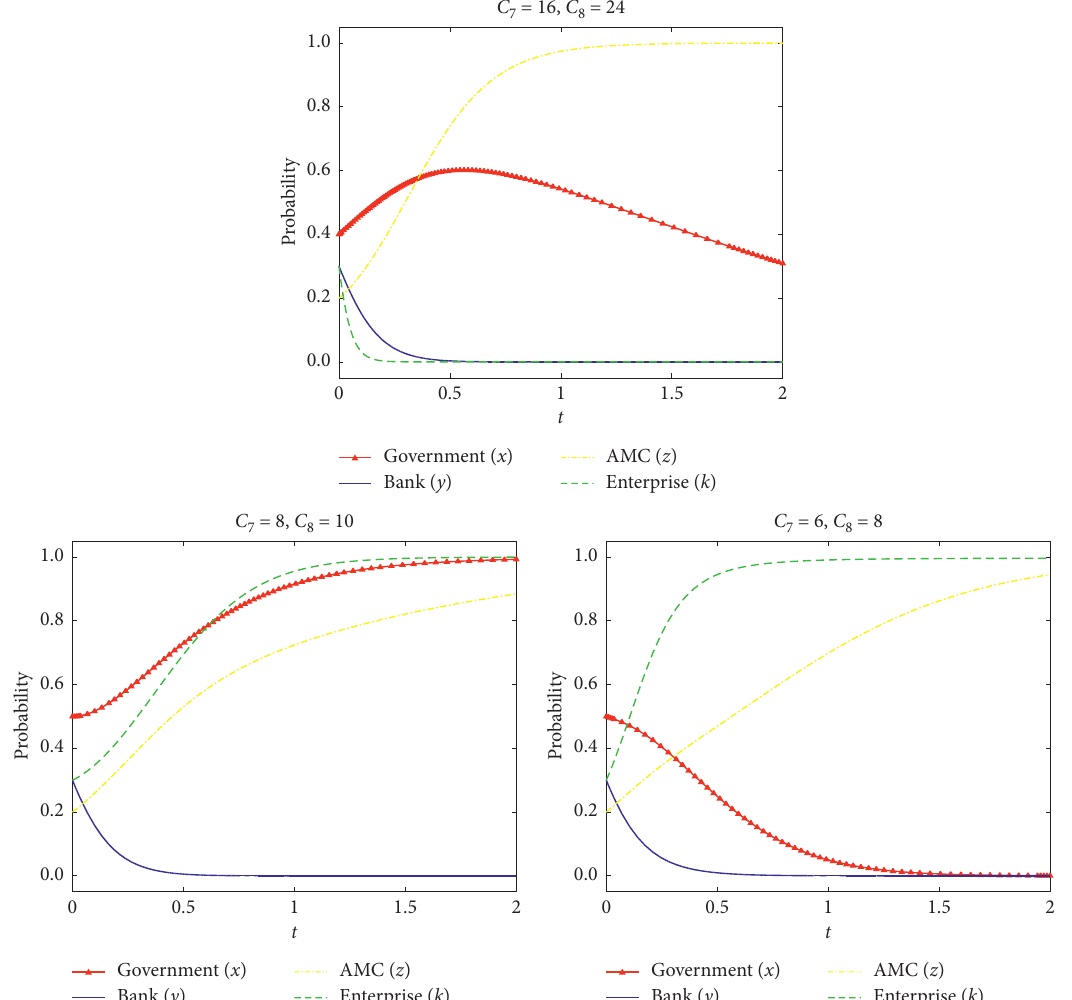
Figure 7: The impact of the cost of hard work on the evolution of each party’s